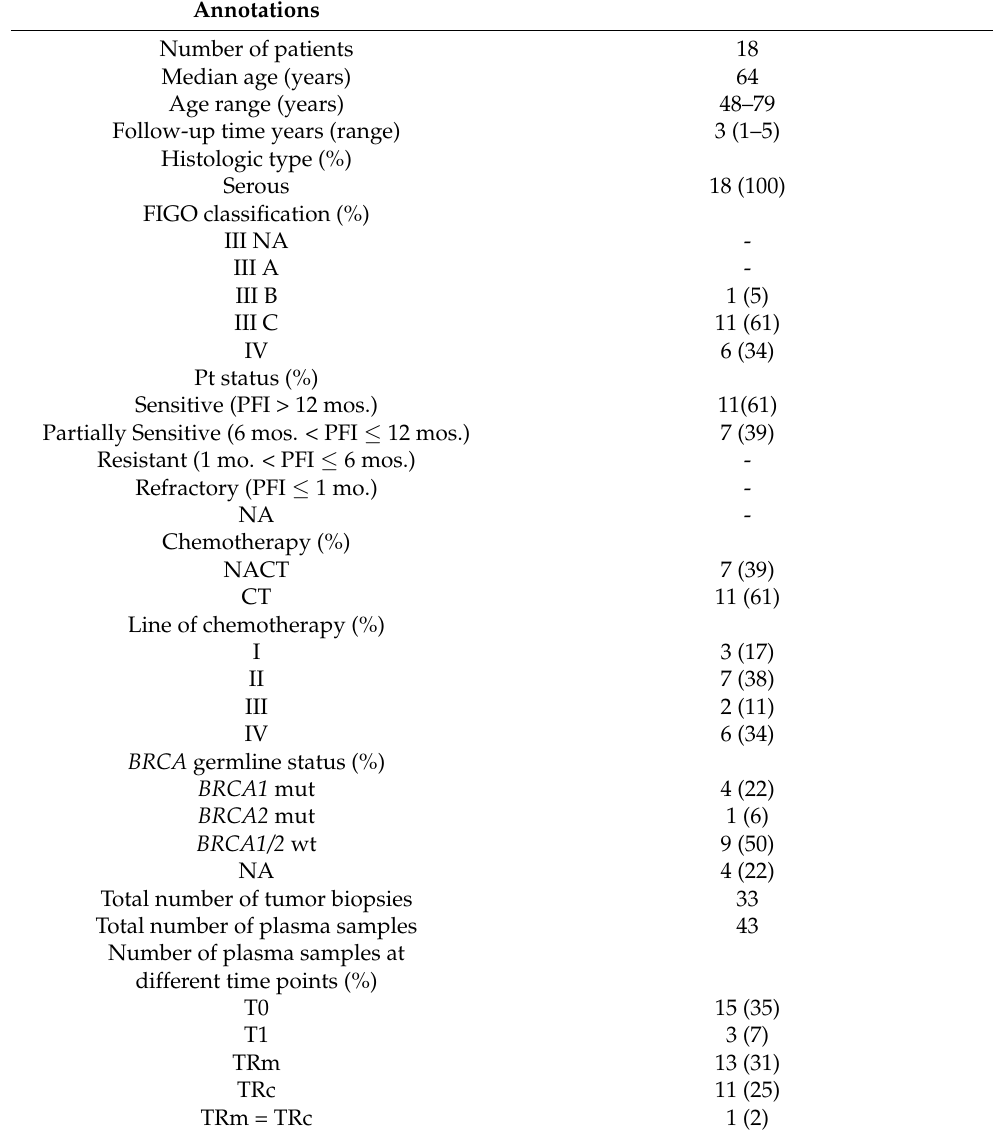
Table 1. Clinical, pathologic, and demographic features of cases enrolled in the study 1